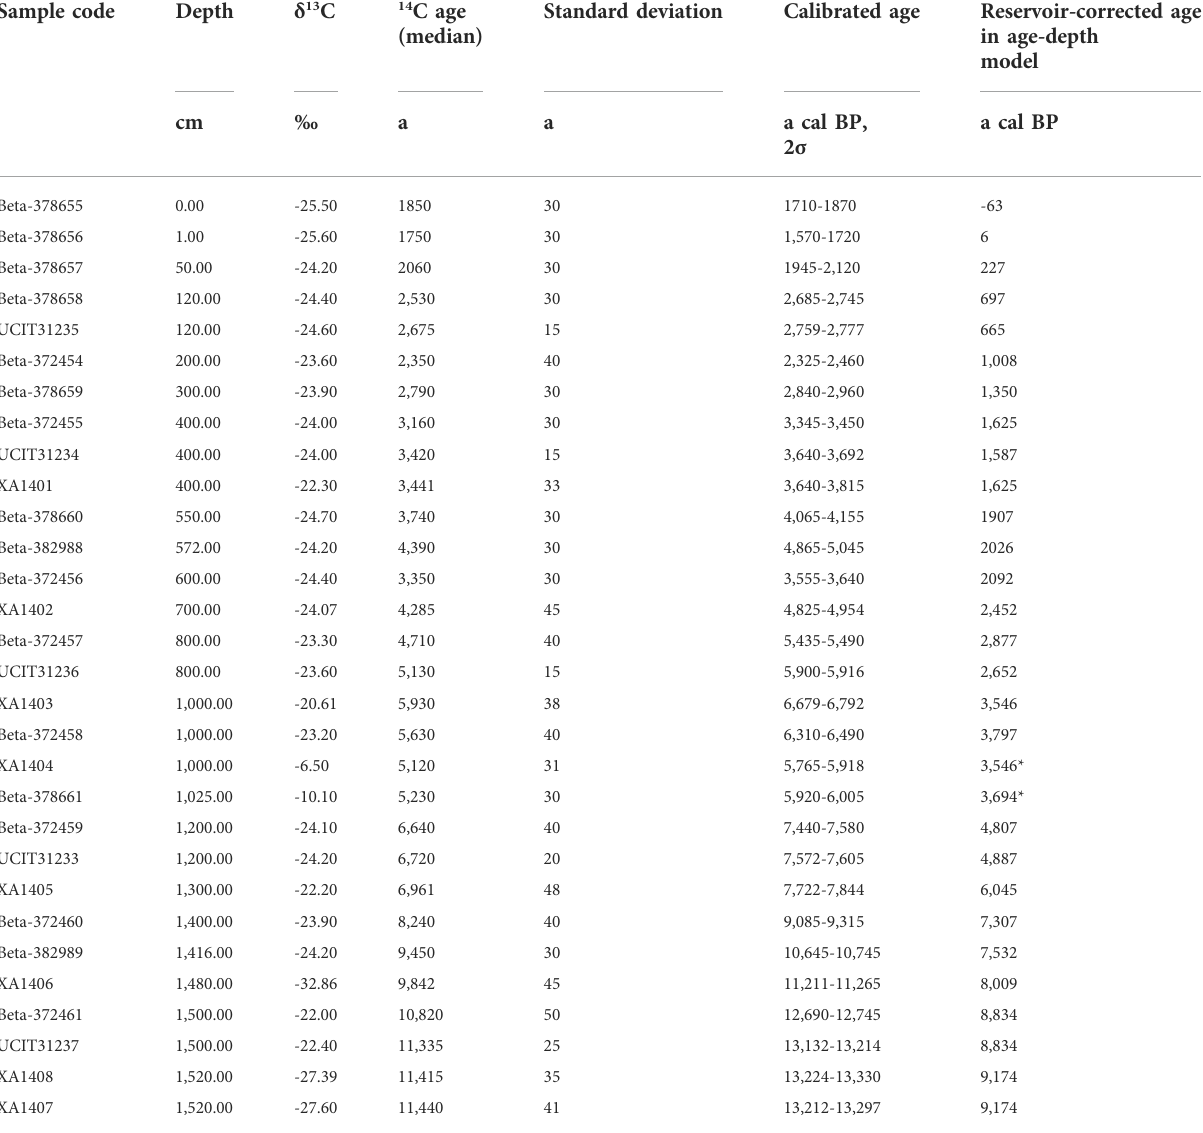
TABLE 4 Measured AMS 14 C ages and reservoir-corrected 14 C ages of dated samples from core KL13-4. *Dates excluded from the